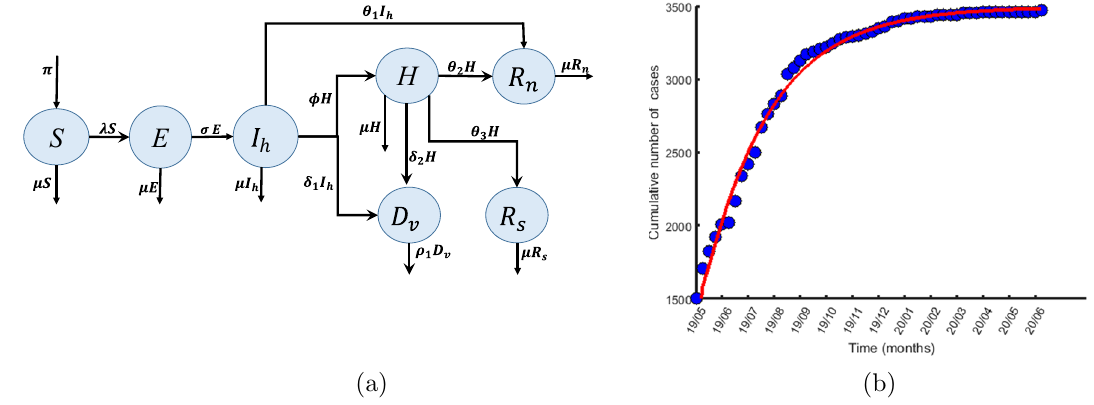
Figure 2. ( a ) Diagram of the model without stigma ( b ) Data fitting of the model in ( a ) to cumulative EVD cases. The data is for the 2019/2020 EVD outbreaks in the DRC extracted from the WHO website, specifically